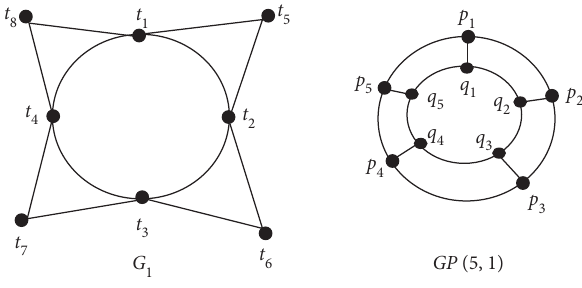
Figure 3: The graphs G